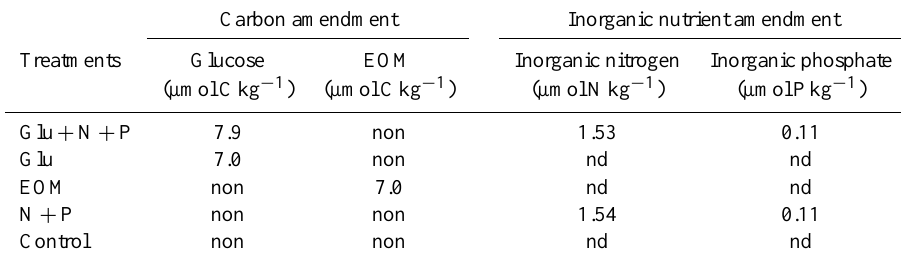
Table 1. Initial organic carbon and inorganic nutrient enrichment treatments in the experiments.